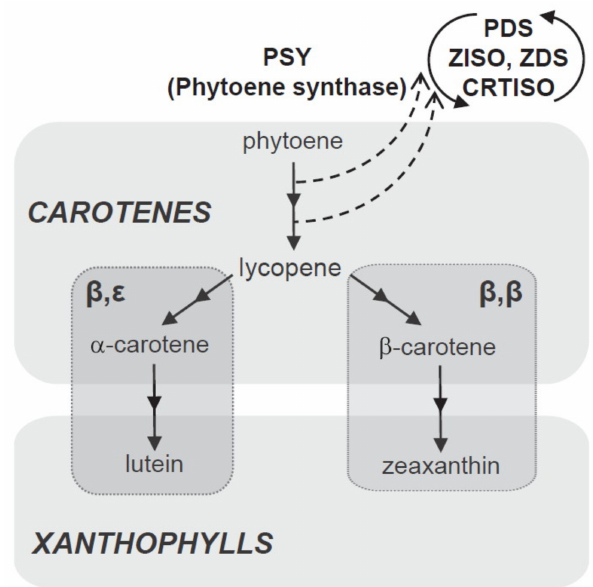
Figure 5. Schematic biosynthetic pathway for